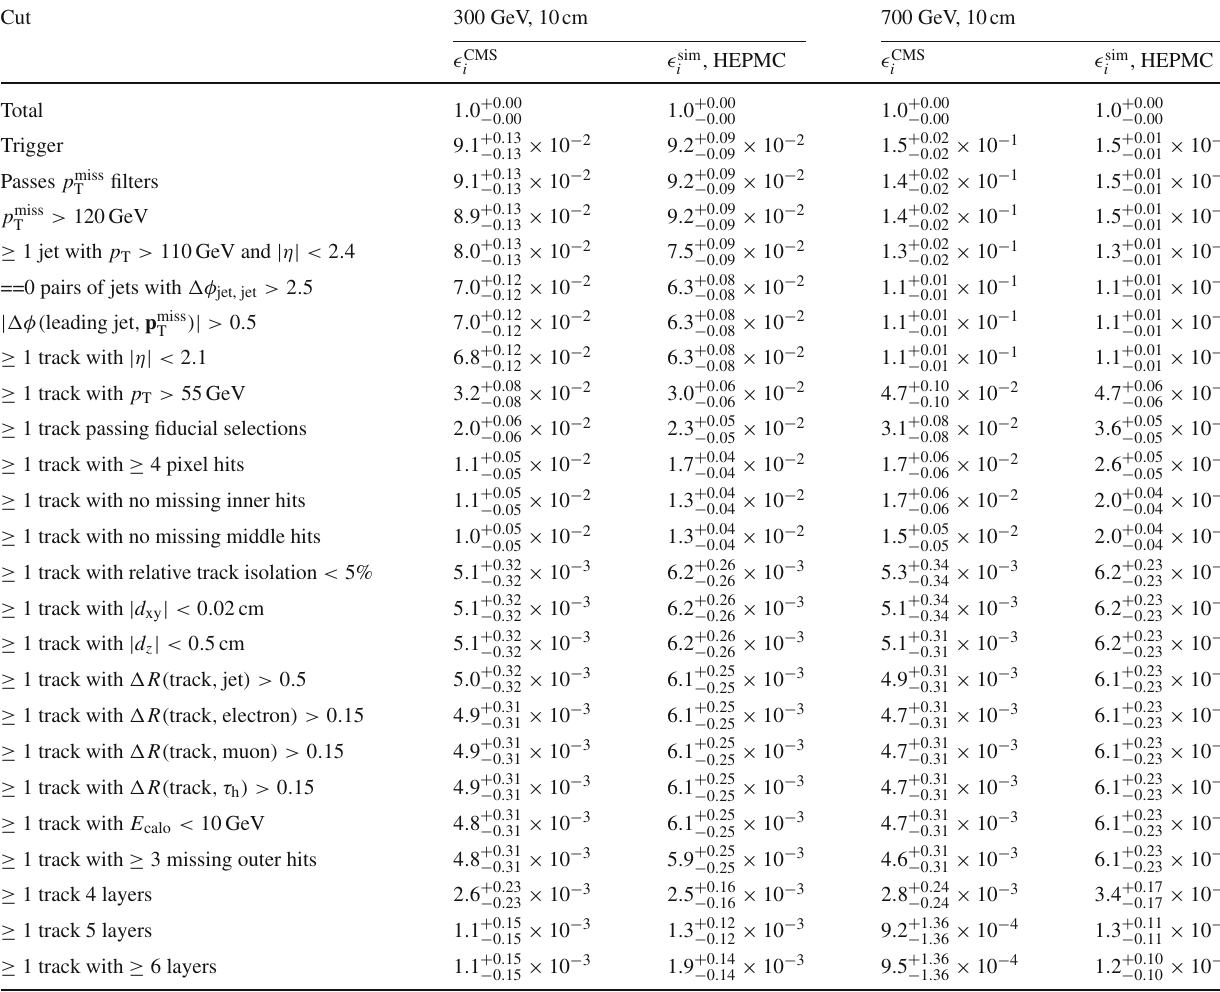
Table 8 Cutflow comparison for signal region 2018A and decay length 10cm, for 300 GeV and 700 GeV winos